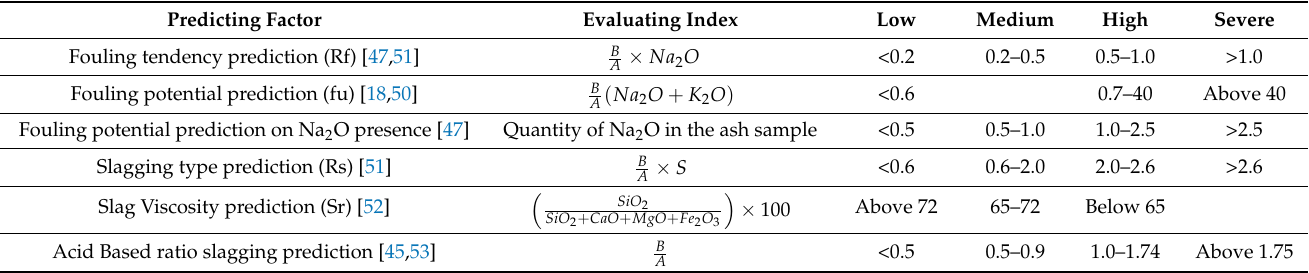
Table 5. Summarised published developed fouling and slagging prediction indices.